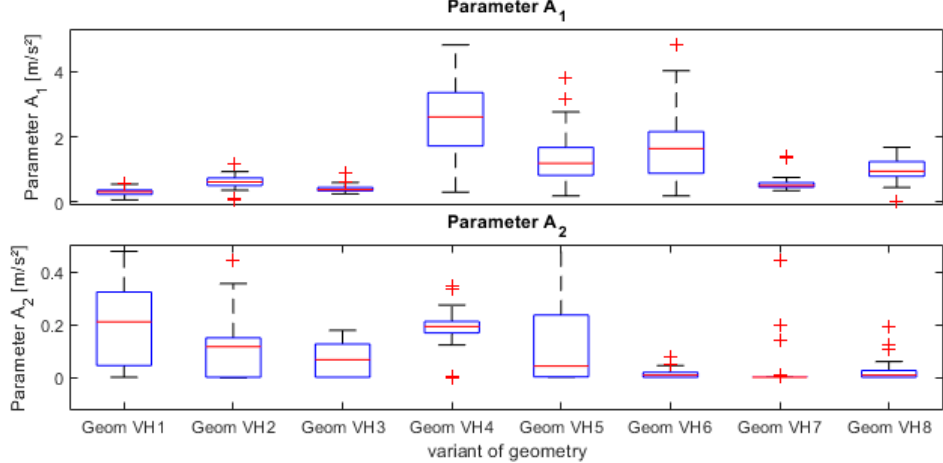
Figure 12. Graphical overview of derived parameters and statistical